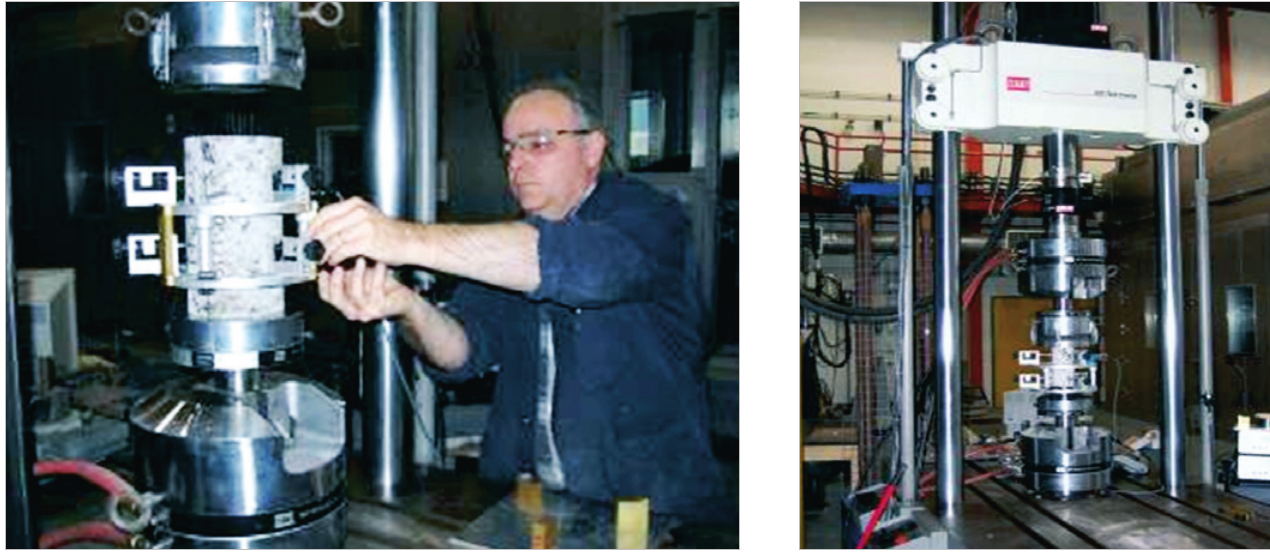
Set-up used for the stiffness damage